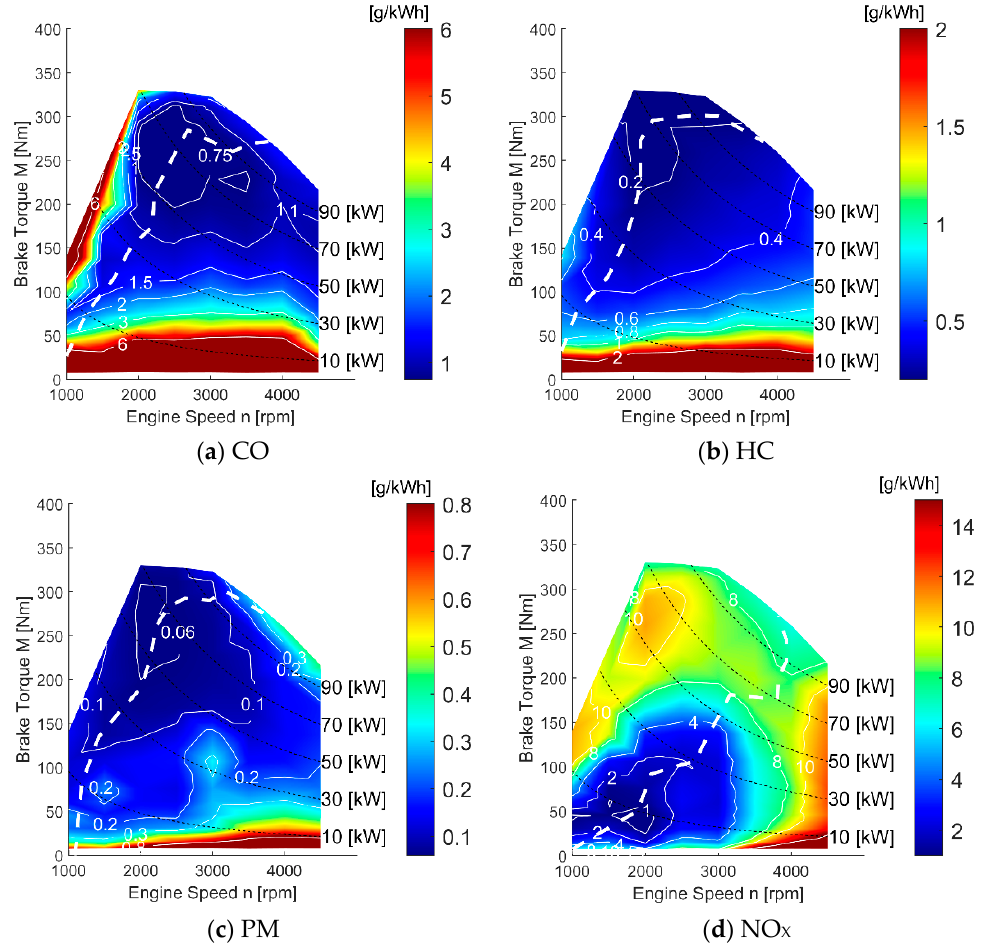
Figure 4. Iso-level and minimal emission curves for ( a ) CO; ( b ) HC; ( c ) PM; ( d ) NO X (white dotted lines).